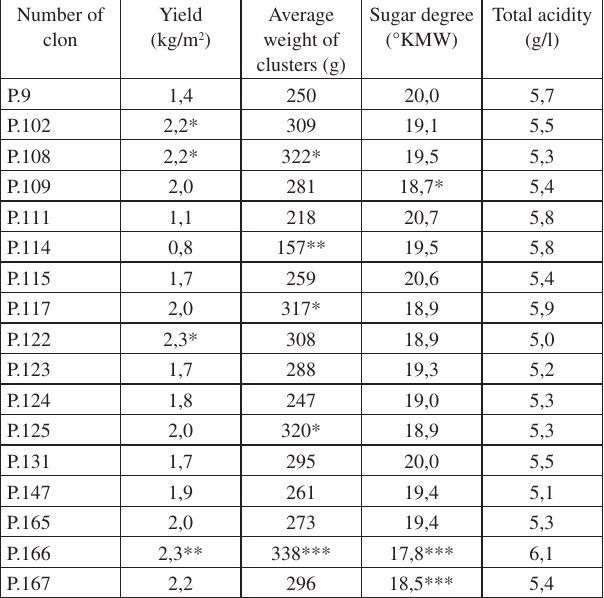
Table 4. Harvest parameters of the clones of ‘Kadarka’ (Szekszárd, Batti field – 2011) Number of clon